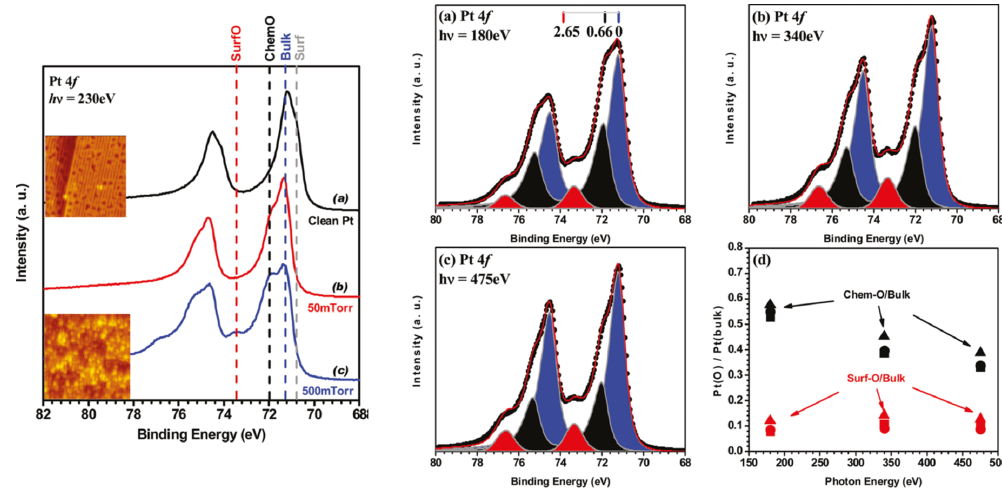
Figure 8. Left panel : Pt 4f X-ray photoelectron spectroscopies (XPS) spectra from clean Pt(110) (black), the obtained under 50 milli Torr O 2 (red), and 500 milli Torr O 2 (blue). Along with indications of the origins of the four components to the spectra. The insets show corresponding STM images of Pt(110) surfaces in two cases. Right panels : deconvolution of the Pt 4f spectra acquired as a function of incident X-ray energy ( a – c ). ( d ) The different behaviors exhibited by two of the states identified as associated with different Pt–O bonding states as a function of X-ray photon energy. The symbols ■ , ● , and ▲ represent data obtained at 300, 373, and 473 K, respectively. Reproduced with permission from J. Am. Chem. Soc . 2011 , 133 , 20319–20325 [134]. Copyright 2011, American Chemical Society.